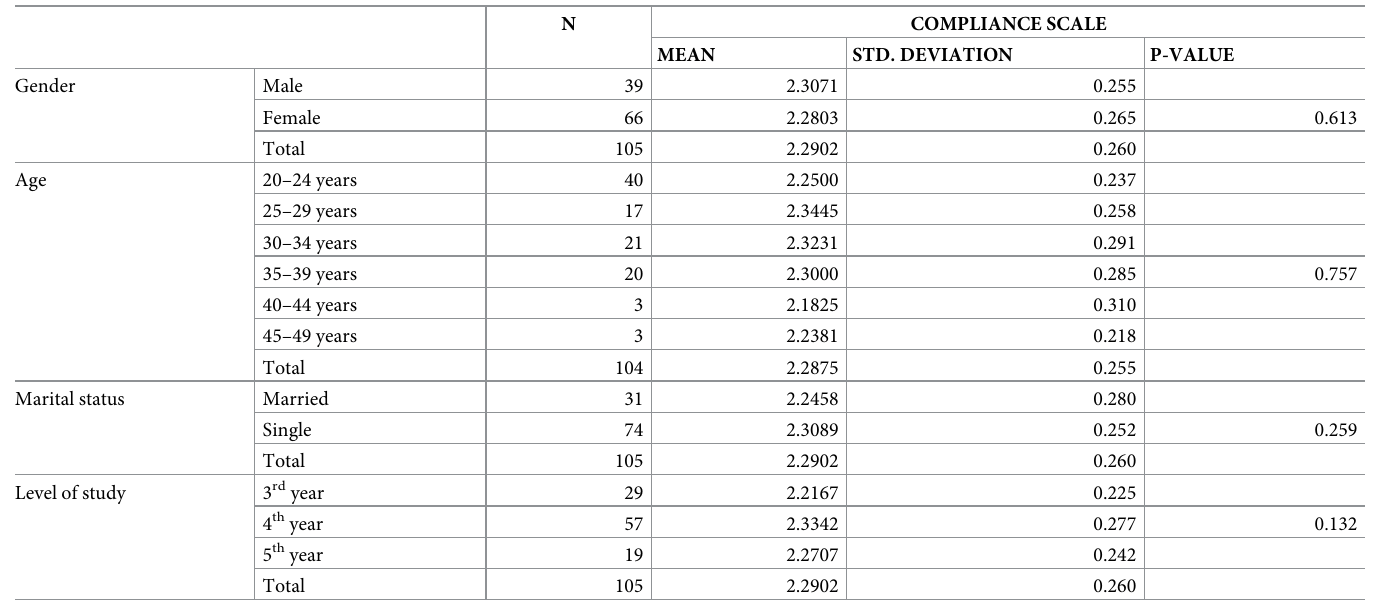
Table 2. Association of each of the research question to the demographics.